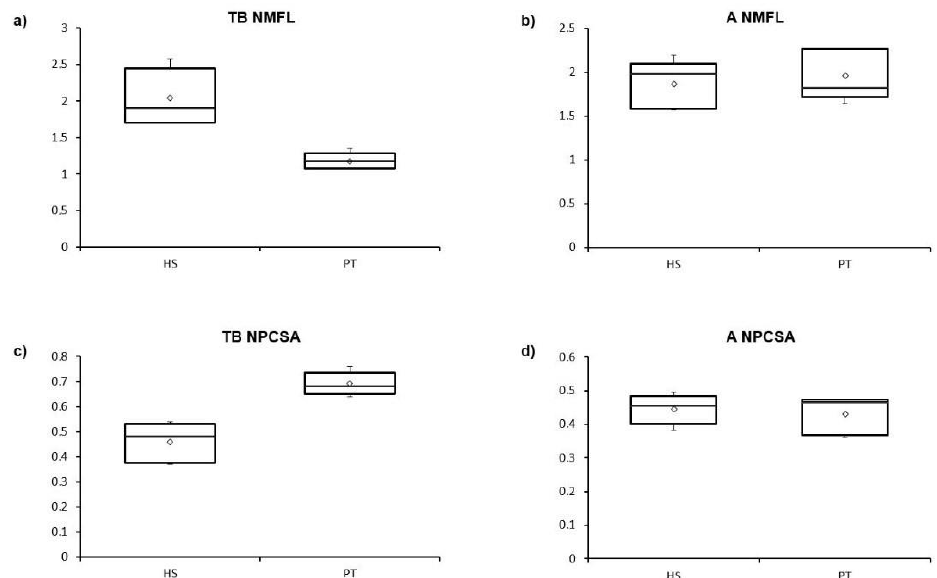
Figure 3. Boxplots of the differences between Homo sapiens (HS) and Pan troglodytes (PT) in NMFL and NPCSA values in the ( a , c ) triceps brachii (TB) and ( b , d ) anconeus (A).